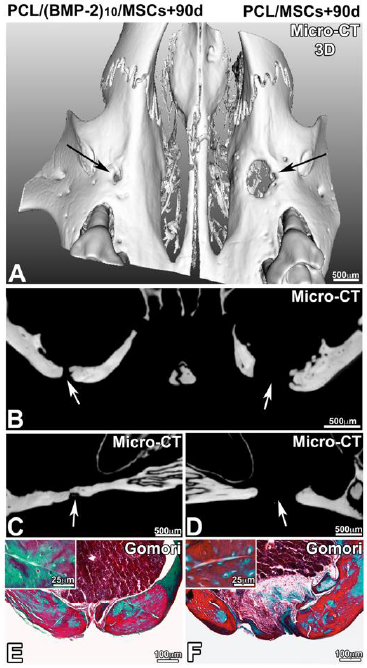
Figure 5. Observation of bone regeneration of the maxillary bone after 90 days of implantation of a PCL membrane functionalized with BMP-2 ( A – C , E ) and non-functionalized ( A , B , D , F ) with hBM-MSCs. A 3D reconstruction ( A ) of frontal ( B ) and sagittal ( C , D ) sections of X-ray microtomography and Gomori trichrome staining ( E , F ).